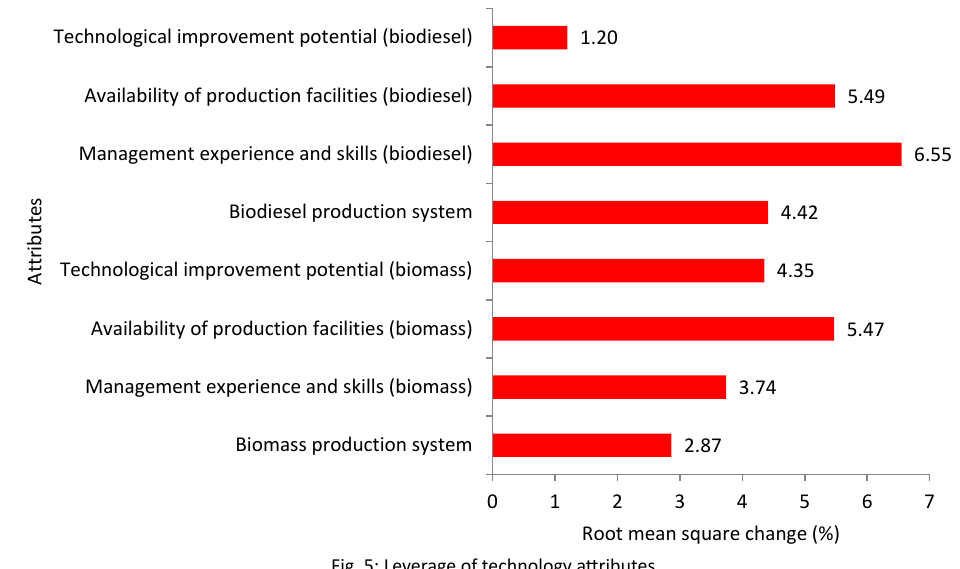
Fig. 5: Leverage of technology attributes